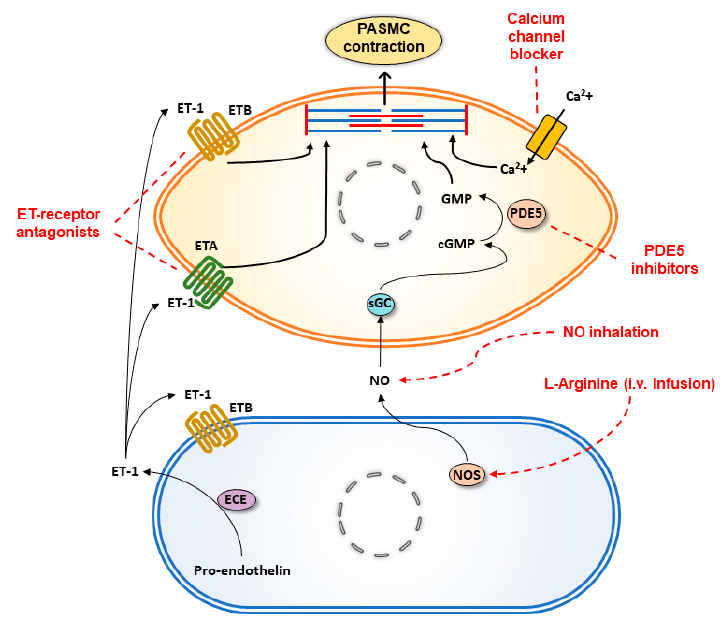
Figure 3. Targets of potential pharmacological agents to prevent or reverse HPV. Upon exposure to hypoxic condition, in pulmonary artery endothelial cells (PAECs), endothelin converting enzyme (ECE) increases endothelin-1 (ET-1) levels, which in turn causes pulmonary artery smooth muscle cell (PASMC) contraction via ET-1 A and B receptors (ETA and ETB). ETA and ETB can be blocked by endothelin receptor antagonists such as bosentan to inhibit hypoxia induced PASMC contraction. Similarly, nitric oxide synthase (NOS) activity is also impaired in hypoxic PAECs, leading to decreased levels of nitric oxide (NO). Further, decreased bioavailability of NO for the activity of soluble guanylate cyclase (sGC) results in decreased levels of cyclic guanosine monophosphate (cGMP) in PASMCs and PASMC contraction. NO level can be restored by either infusion of L-arginine, which is used by NOS as a substrate, or by NO inhalation, which directly activates sGC. To prevent cGMP degradation in PASMCs, phosphodiesterase type 5 (PDE5) can be inhibited by PDE5 inhibitors such as sildenafil and tadalafil. In addition, calcium influx and PASMC contraction can be inhibited with calcium channel blockers such as nifedipine. Table 1. Summary of relevant studies evaluating effects of potential drugs on HPV in in vitro, ex vivo, and in vivo rodent models. Drugs